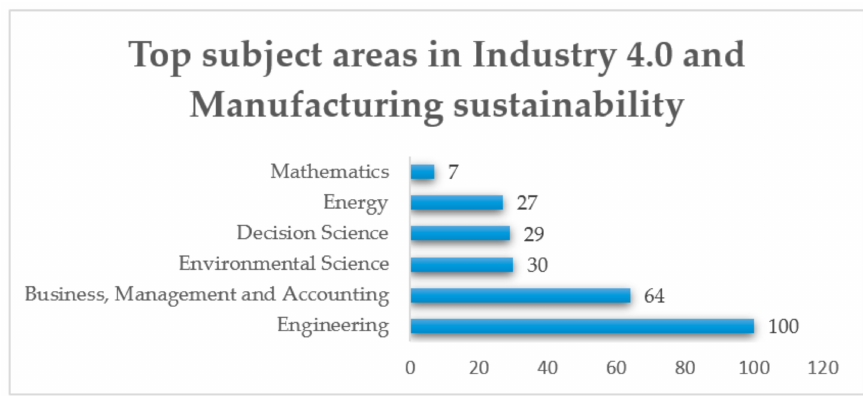
Figure 4. Articles distributed based on subject areas.